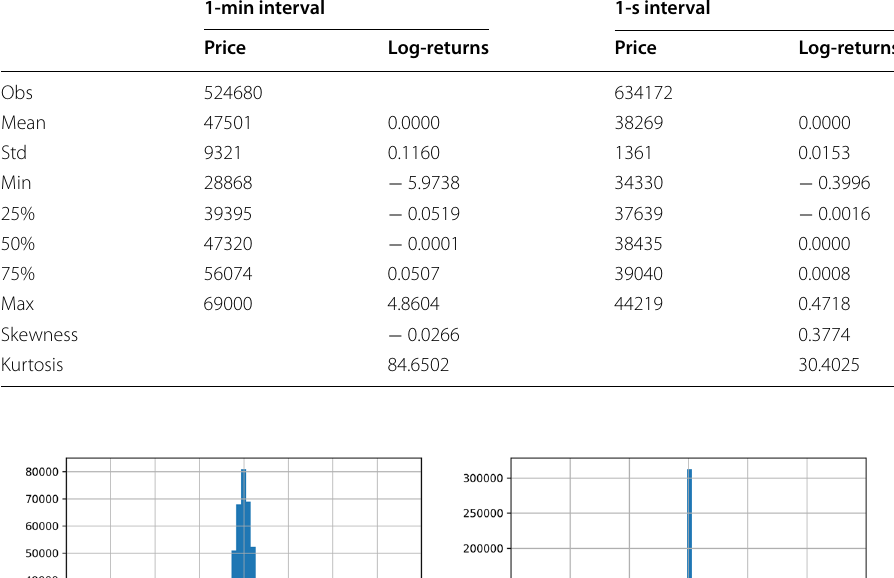
Table 2 Summary statistics of the Bitcoin price (USD) and log-returns (%) for 1-min and 1-s intervals